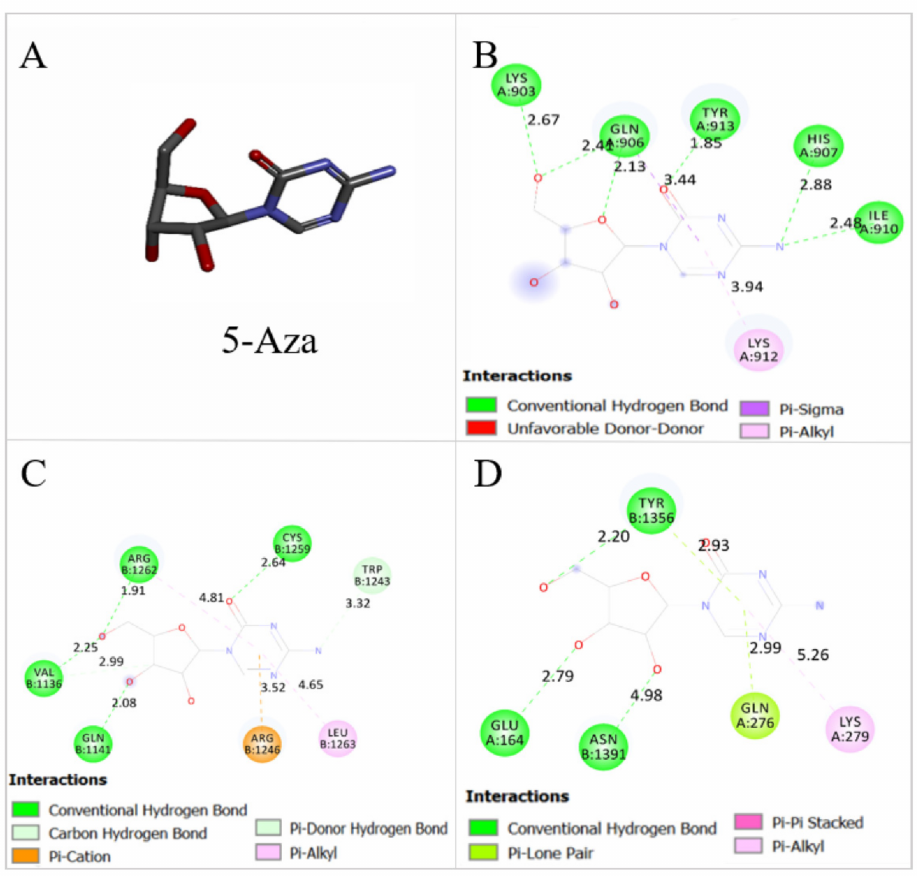
Figure 9. ( A ) Crystallography structure of the positive control, 5-Aza. The interactions between the 5-Aza and the studied proteins ( B ) JAK2 , ( C ) STAT3 , and ( D ) STAT5. Table 4. Free binding energy (FBE) of TQ and 5-Aza after interaction with studied